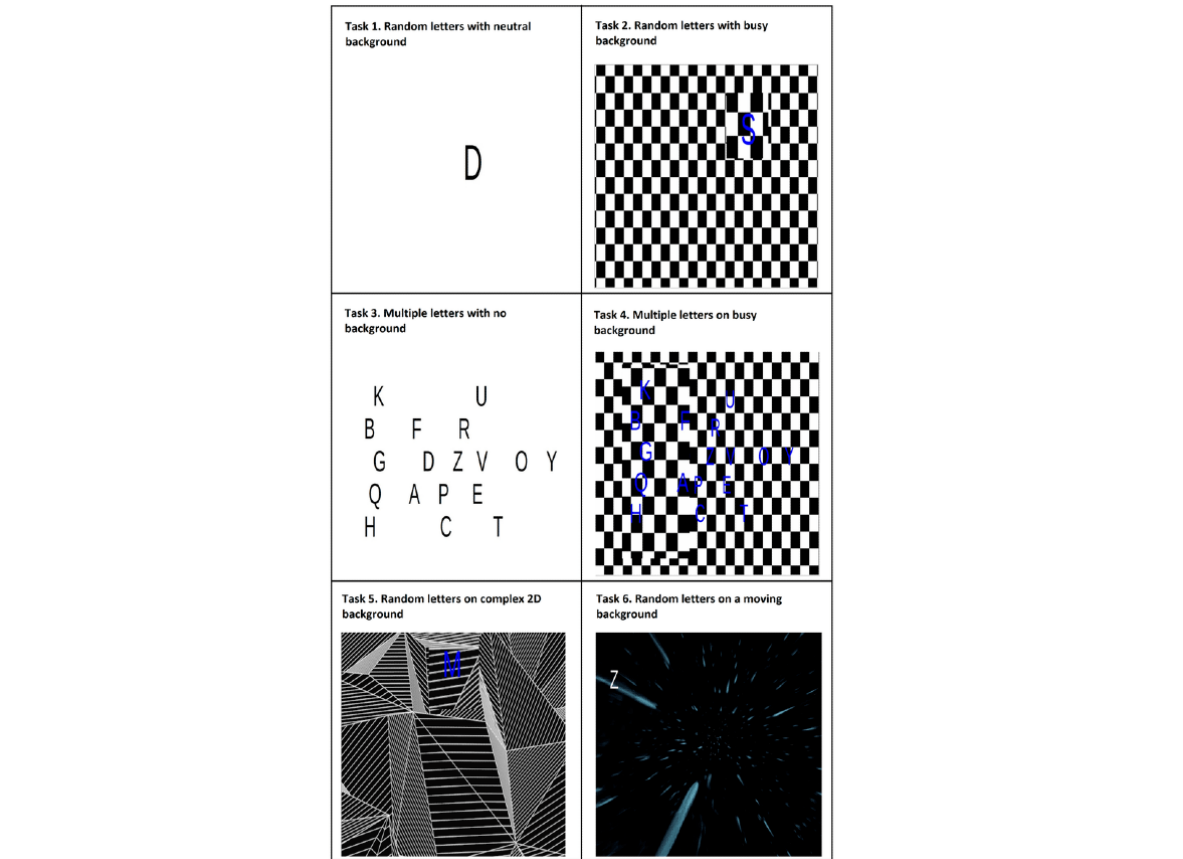
Figure 4. The experimental tasks. *Letters have been magnified for clear visibility.